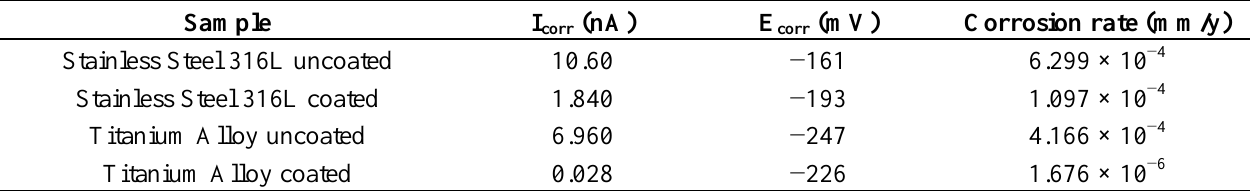
Table 1. Values of the potentiodynamic polarization